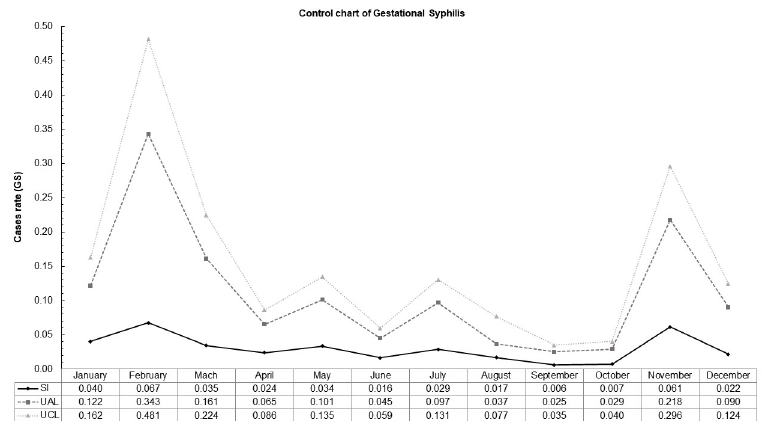
Fig 4. Control chart of monthly cases of gestational syphilis notified in the Pontal do Paranapanema from 2008 to 2013. SI = Seasonal index; UAL = Upper Alert Limit; UCL = Upper Control Limit. Highest amplitude of cases was identified in February followed by November, without overlap of UAL and UCL. Lowest amplitude was noticed in September and October. Inferior alert and control limits are not present as that results were lower than zero. Databases: Brazilian Institute of Geography and Statistics—IBGE (2010) and National System of Aggravations and Notification–SINAN (2017).